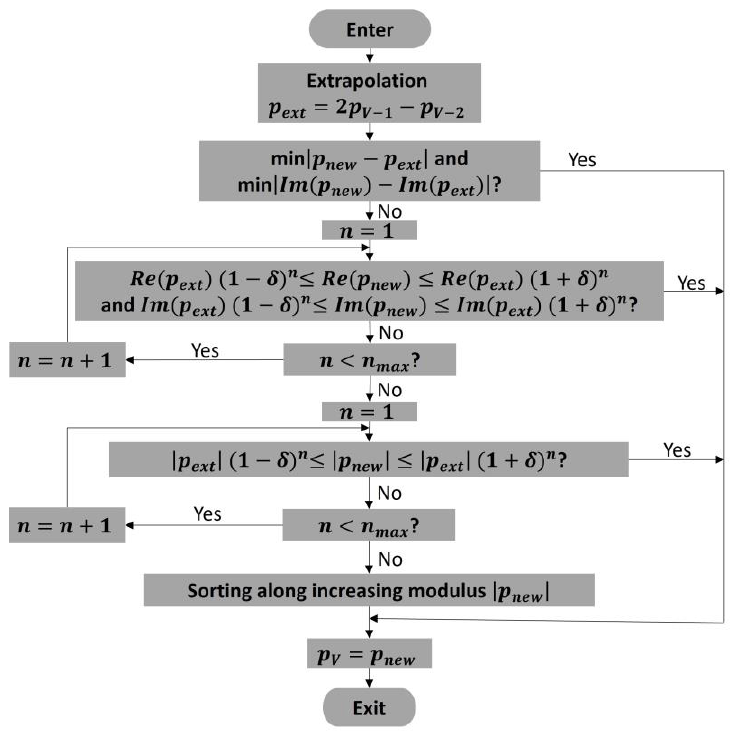
Figure 2. Flow chart of the predict-and-select mode tracking procedure.